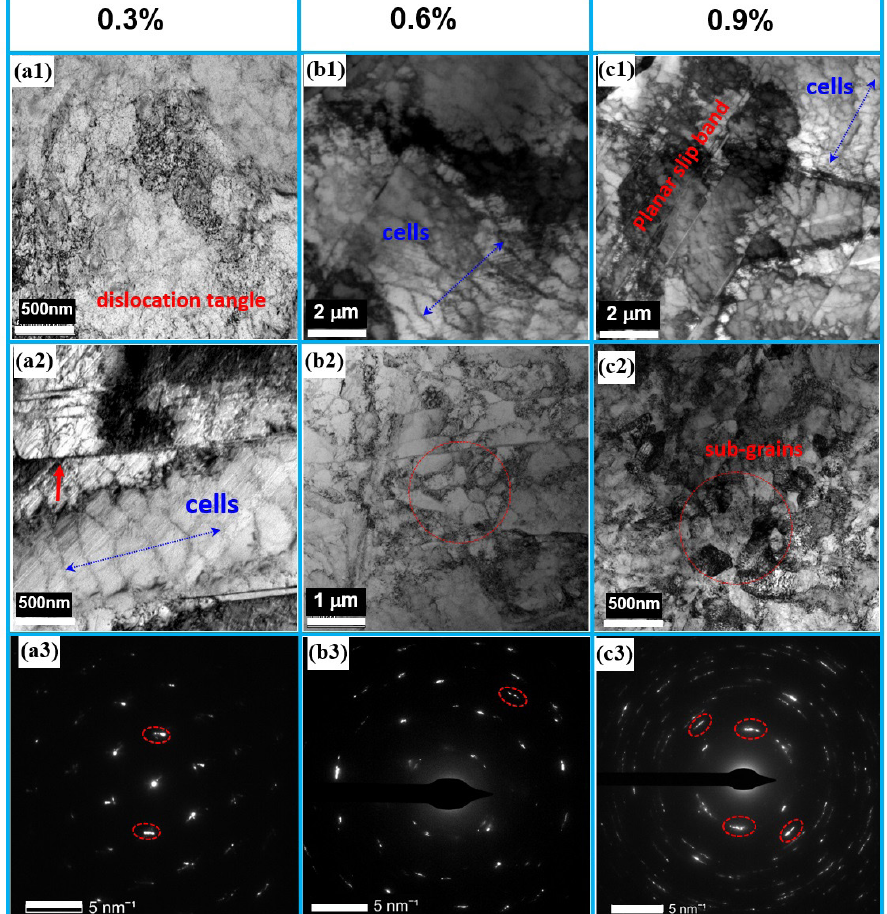
Figure 6. TEM images of cell structures in the fractured samples. (a1-a2) TEM images and (a3) SAED pattern of the cell in (a2); (b1-b2) TEM images and (b3) SAED pattern of the cell in (b2); (c1-c2) TEM images and (c3) SAED pattern of the cell in (c2).